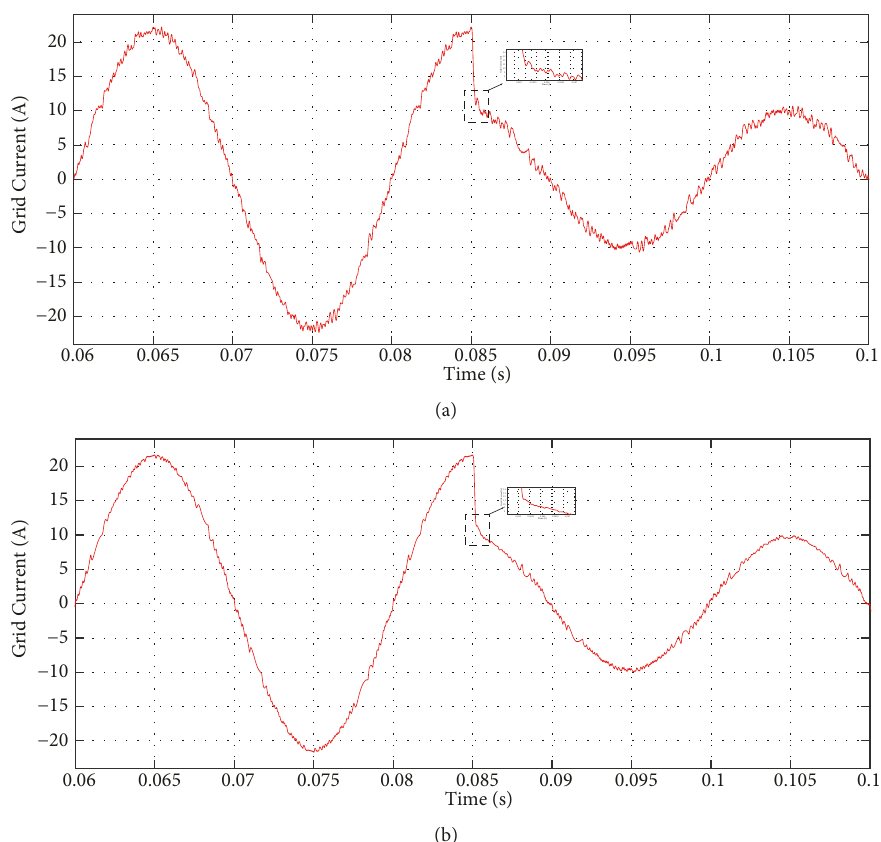
Figure 12: Grid current of phase A for (a) the conventional MPVC and (b) the proposed MPVC.